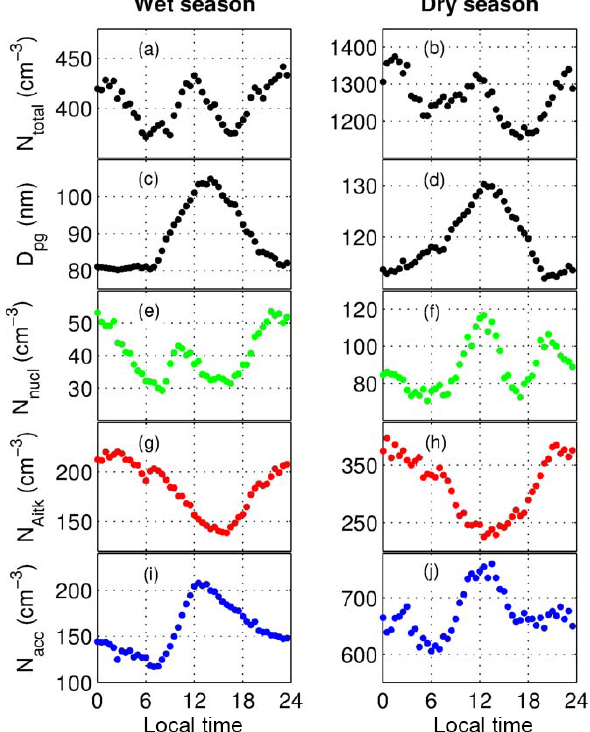
Figure 3. Median diurnal cycles for the wet and dry seasons. Total particle number concentration in the 10–600nm range ( N total ) (a, b) ; particle mean geometric diameter ( D pg ) (c, d) ; concentration of the nucleation mode ( N nucl ) (e, f) ; concentration of the Aitken mode ( N Aitk ) (g, h) ; and the concentration of the accumulation mode ( N acc ) (i, j)